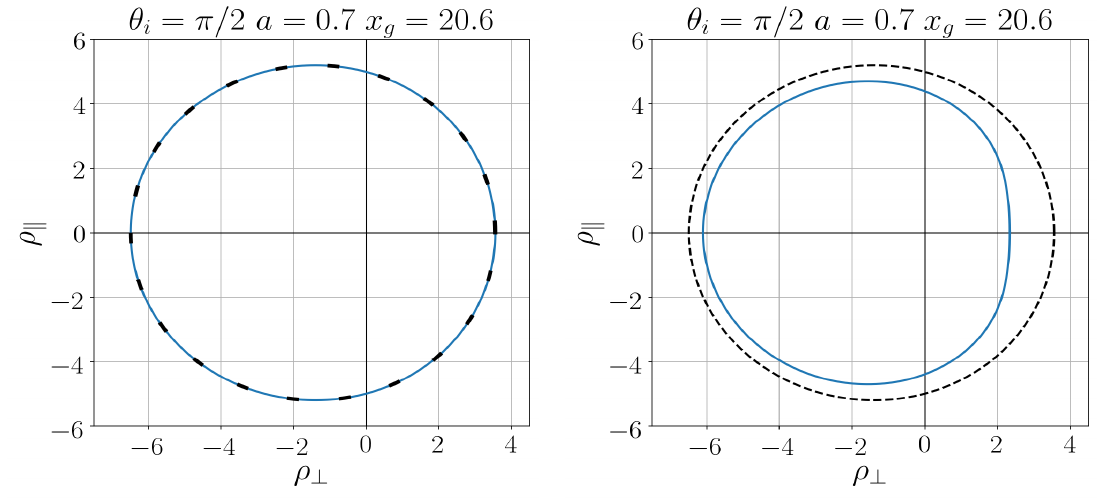
Figure 7. Comparison of shadows for the case of the density profile (7) ( Left ) and for the case of the density profile (26) ( Right ) for a = 0.7. An observer angular coordinate θ i = π /2.